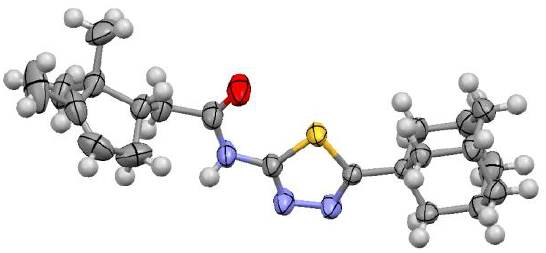
Figure 3. Crystal structure for compound 15b (50% probability ellipsoids).